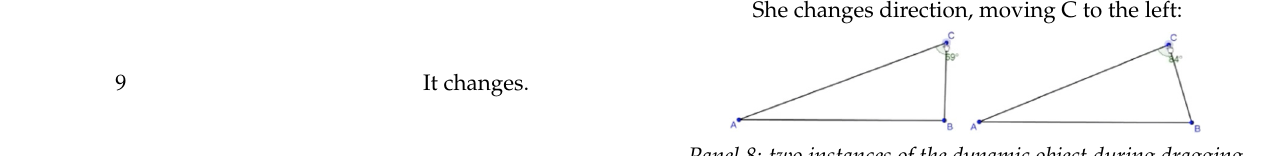
Panel 7: two instances of the dynamic object during dragging She changes direction, moving C to the left: